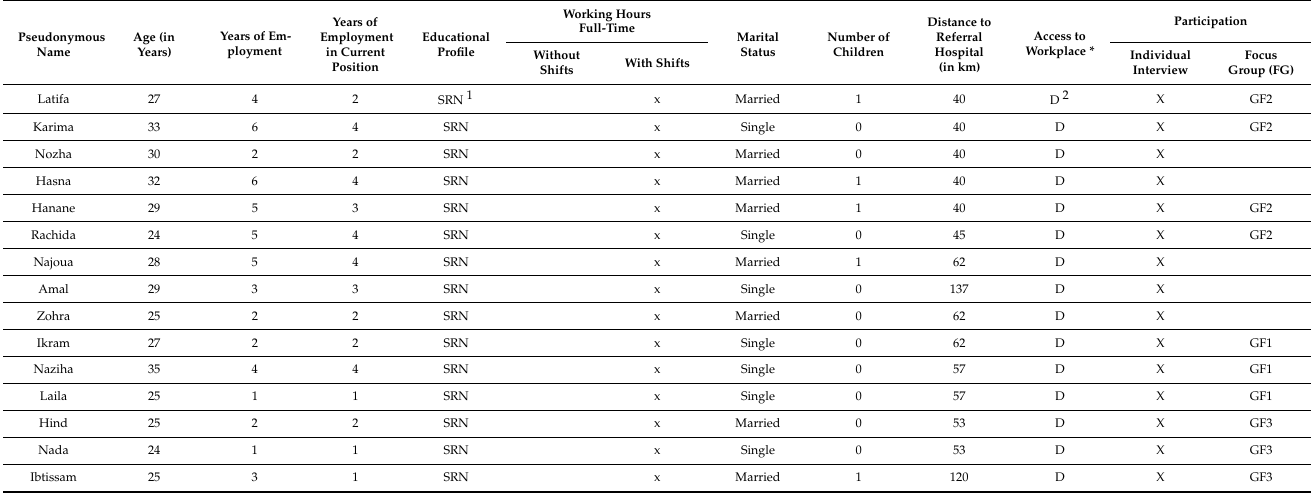
Table 2. Description of specific socio-demographic characteristics of the sample (n =